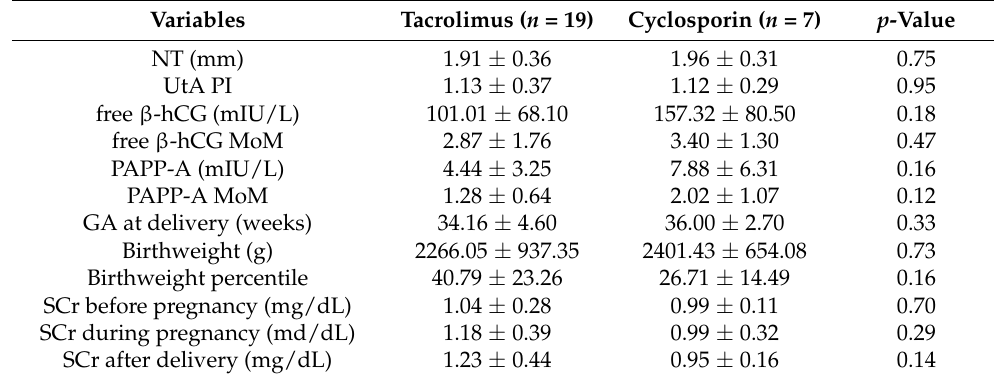
Table 4. Comparison of screening parameters and perinatal outcomes between two immunosuppres- sive therapy